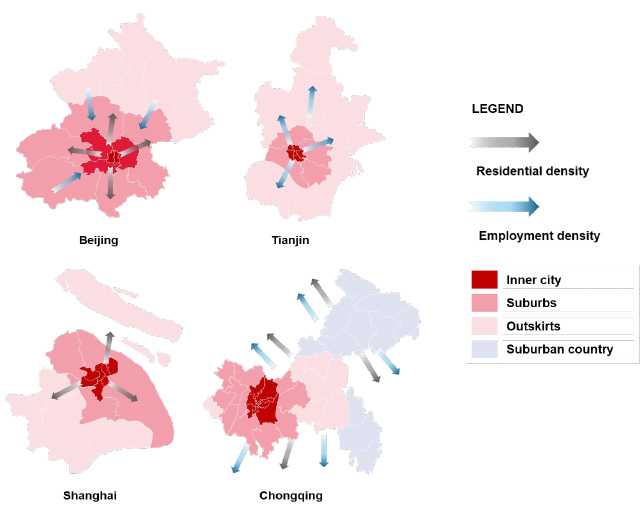
Figure 3 . Residential employment centre